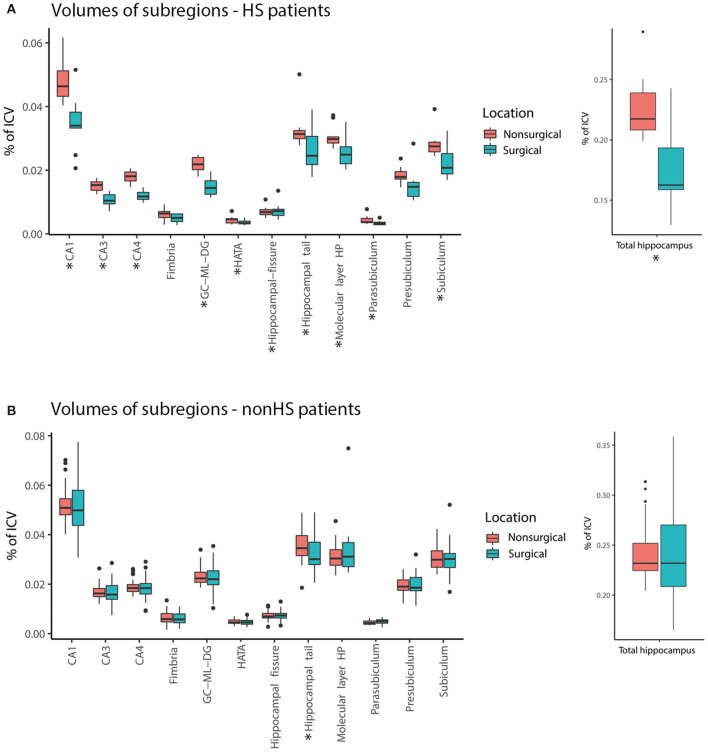
Comparison of volume [in % of total intracranial volume (ICA)] of hippocampal subregions surgical (blue) and nonsurgical (pink) hemispheres for hippocampal sclerosis patients (HS) (A) and non-hippocampal sclerosis (non-HS) patients (B). The total hippocampus and many subregions were smaller in the surgical hemisphere compared to the nonsurgical hemisphere in the HS group, but not in patients without HS (* = statistically significant, p < 0.05).